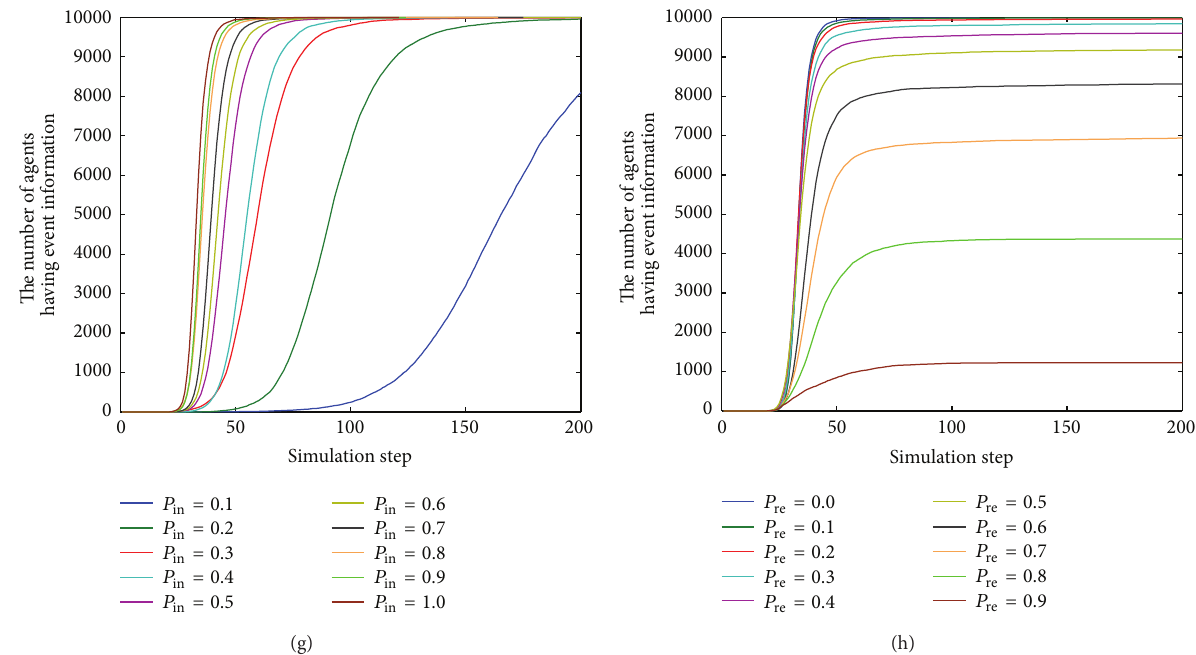
Figure 7: Parameters difference influence on the strategies effectiveness. (a), (c), (e), and (g) interaction probability strategy. (b), (d), (f), and (h) Communication intervention strategy.